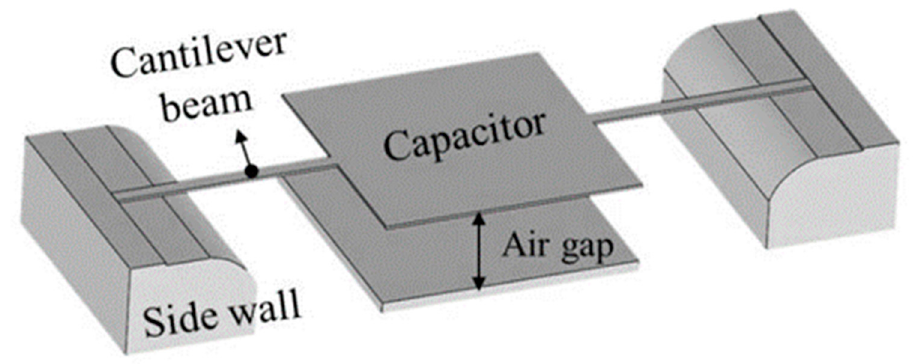
Figure 1. A schematic diagram of the novel MEMS capacitor. The location of the stiffness variation is described by the following equation [9].